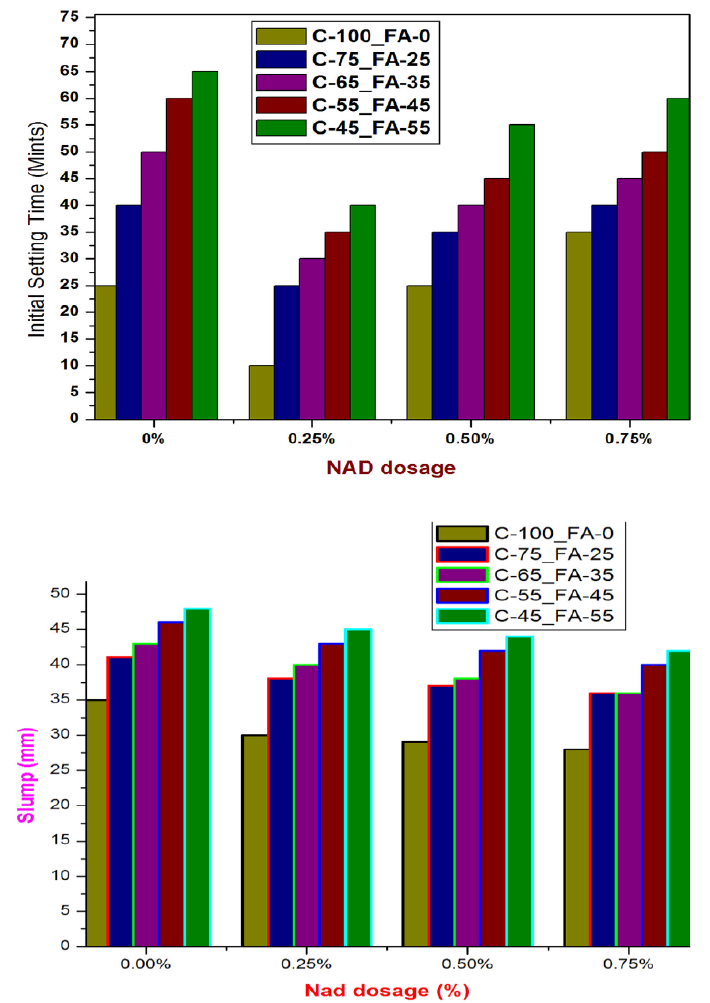
Figure 14. Test results Broiler egg with different Class F fly ash effecting on concrete properties